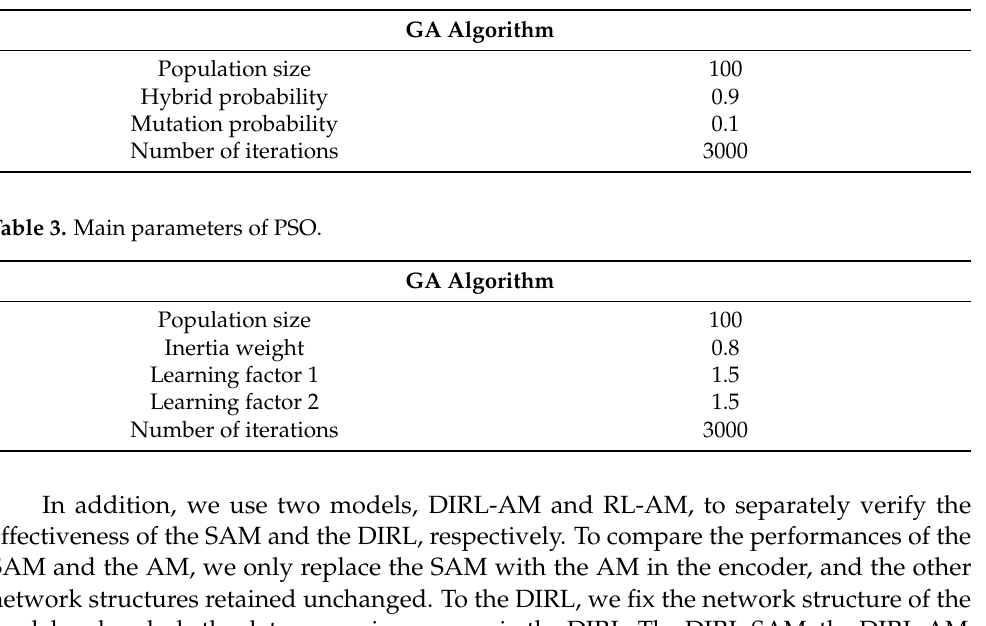
Table 2. Main parameters of GA.